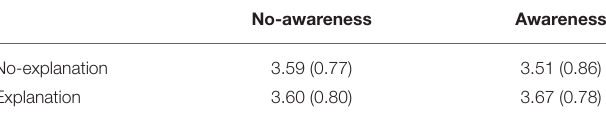
TABLE 4 | Means and standard deviations (in brackets) of perceived autonomy for each of the experimental conditions.